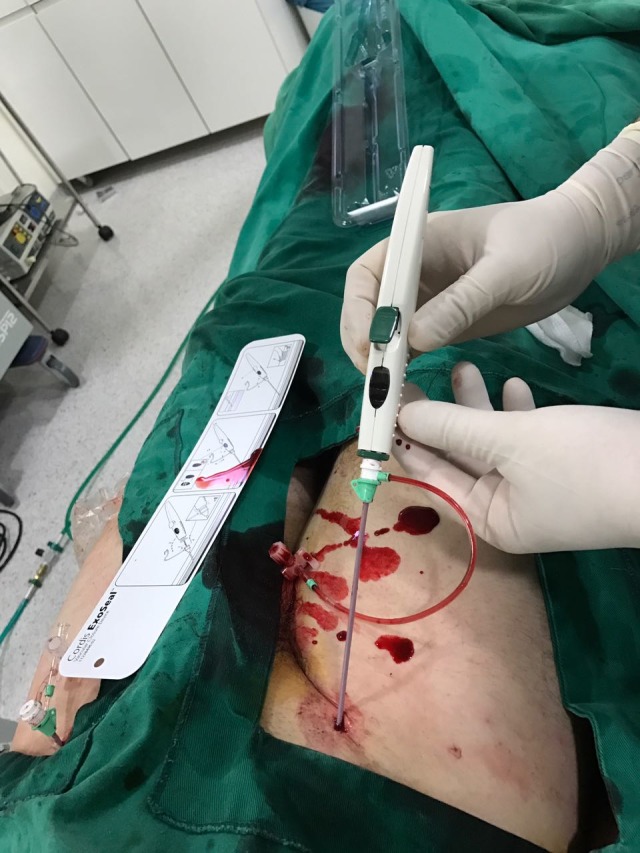
Proper positioning of the device.